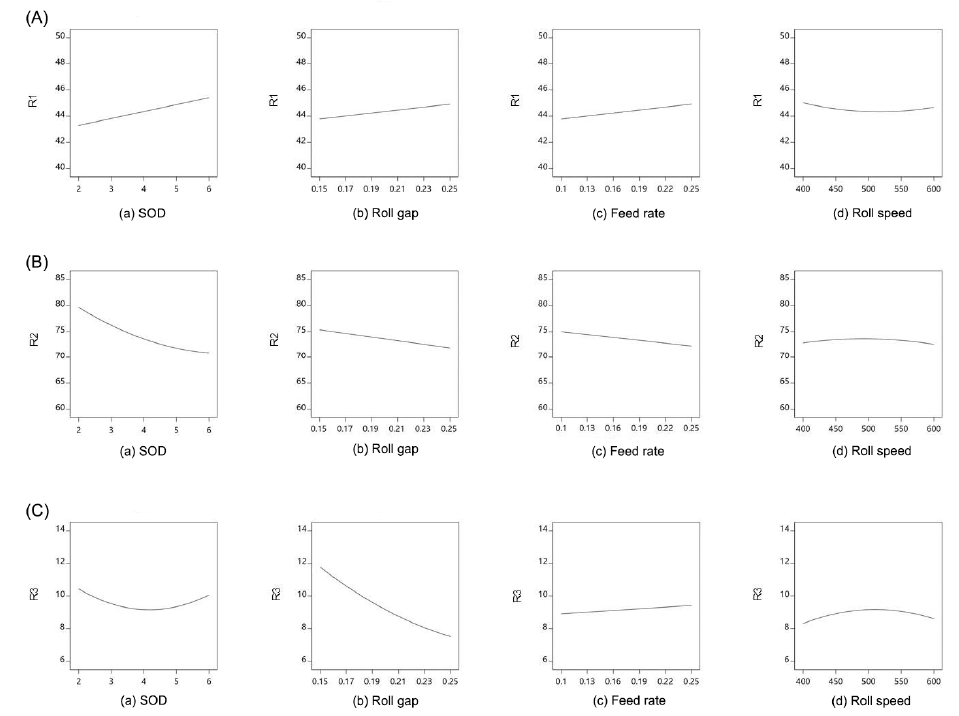
Figure 3. The influence of the observed parameters on the: ( A ) protein content; ( B ) fraction yield; and ( C ) grinding energy consumption.